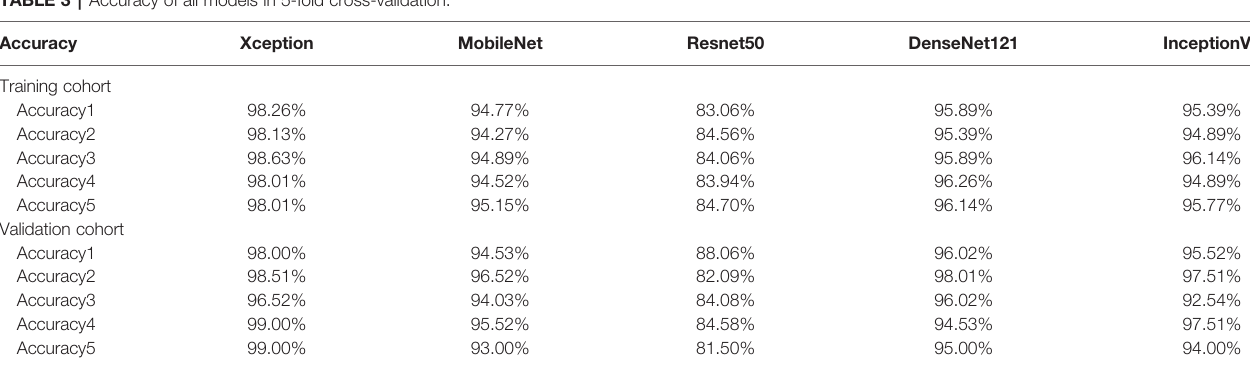
TABLE 3 | Accuracy of all models in 5-fold cross-validation.